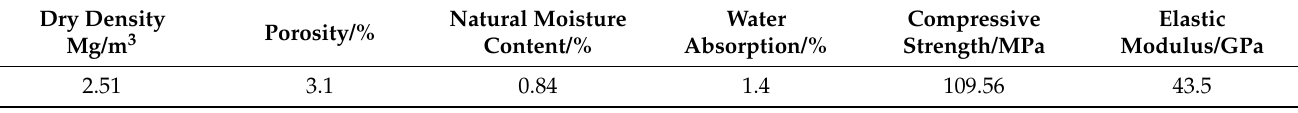
Table 1. Physical and mechanical properties of